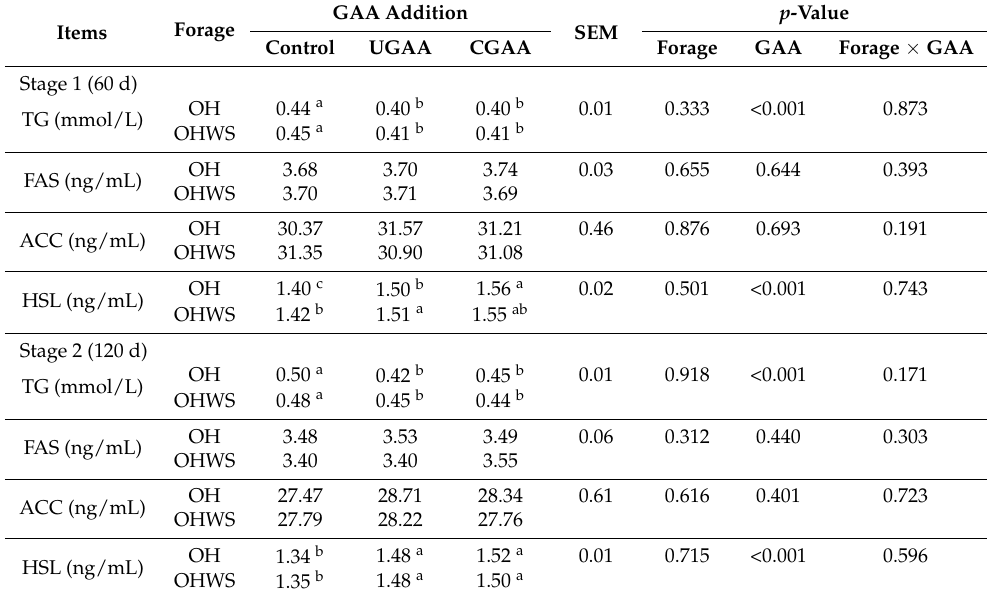
Table 5. Effects of forage type and GAA addition on serum indexes in feedlotting